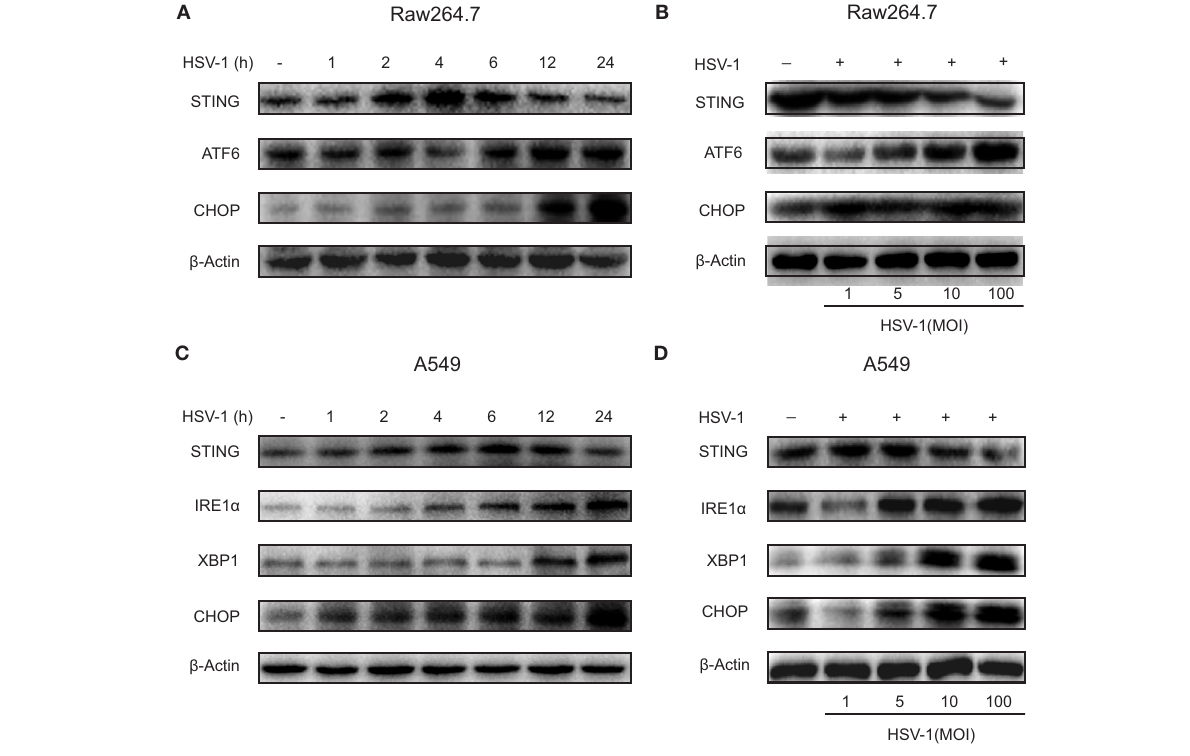
FigUre 4 | Herpes simplex virus type 1 (HSV-1) infection-induced endoplasmic reticulum stress and downregulated stimulator of interferon genes (STING) protein expression in Raw264.7 cells and A549 cells. (a) Representative Western blot image of the time course of the protein expression of STING, activating transcription factor 6 (ATF6), and C/EBP homologous protein (CHOP) in Raw264.7 cells treated with HSV-1 [multiplicity of infection (MOI) 5] for 0, 1, 2, 4, 6, 12, or 24 h. (B) Representative Western blot image of the dose response of the protein expression of STING, ATF6, and CHOP in Raw264.7 cells treated with HSV-1 (MOI 1, 5, 10, or 100) for 6 h. (c) Representative Western blot image of the time course of the protein expression of STING, inositol-requiring enzyme 1 α (IRE1 α ), X-box protein 1 (XBP1), and CHOP in A549 cells treated with HSV-1 (MOI 5) for 0, 1, 2, 4, 6, 12, or 24 h. (D) Representative Western blot image of the dose response of the protein expression of STING, IRE1 α , XBP1, and CHOP in A549 cells treated with HSV-1 (MOI 1, 5, 10, or 100) for 6